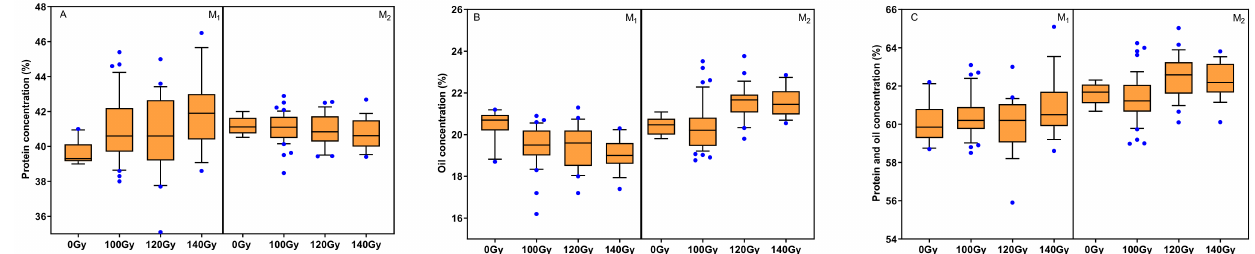
Figure 5. The distribution of seed protein concentration and oil concentration in the M 1 and M 2 populations. ( A ) Protein concentration; ( B ) oil concentration; ( C ) protein and oil